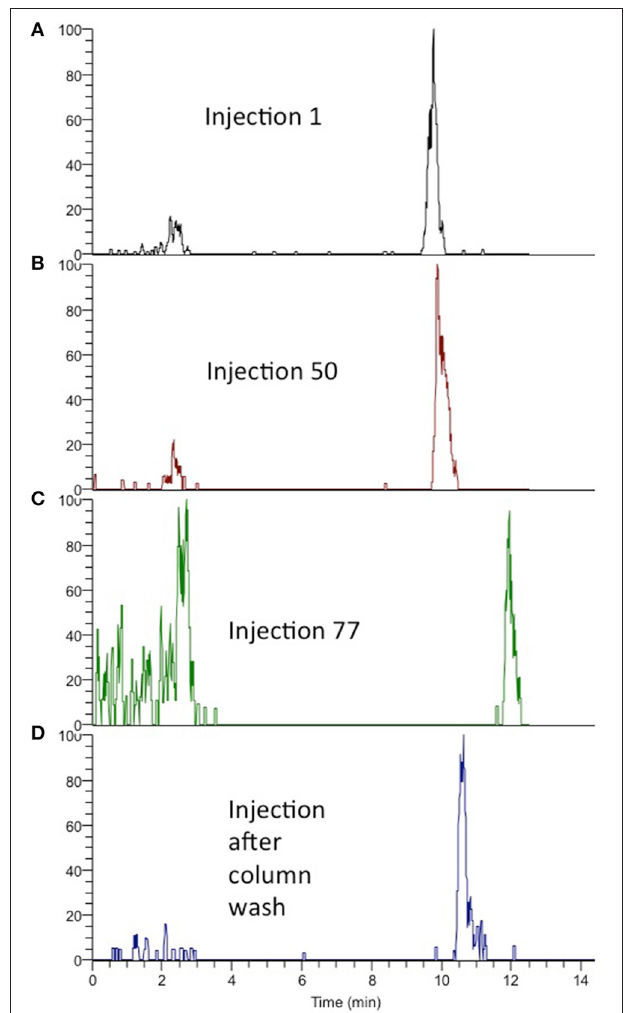
FIGURE 2 | (A) Retention of sulfamethoxazole, injection no. 1. (B) Retention after 50 injections. (C) Retention after 77 injections. (D) Retention after washing procedure (95%